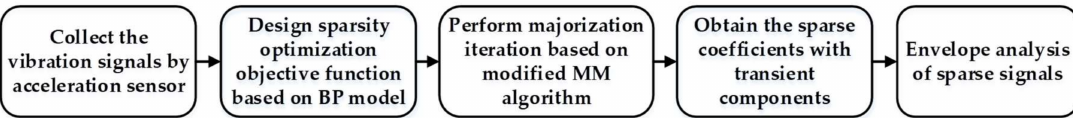
Figure 1. Flowchart of the proposed